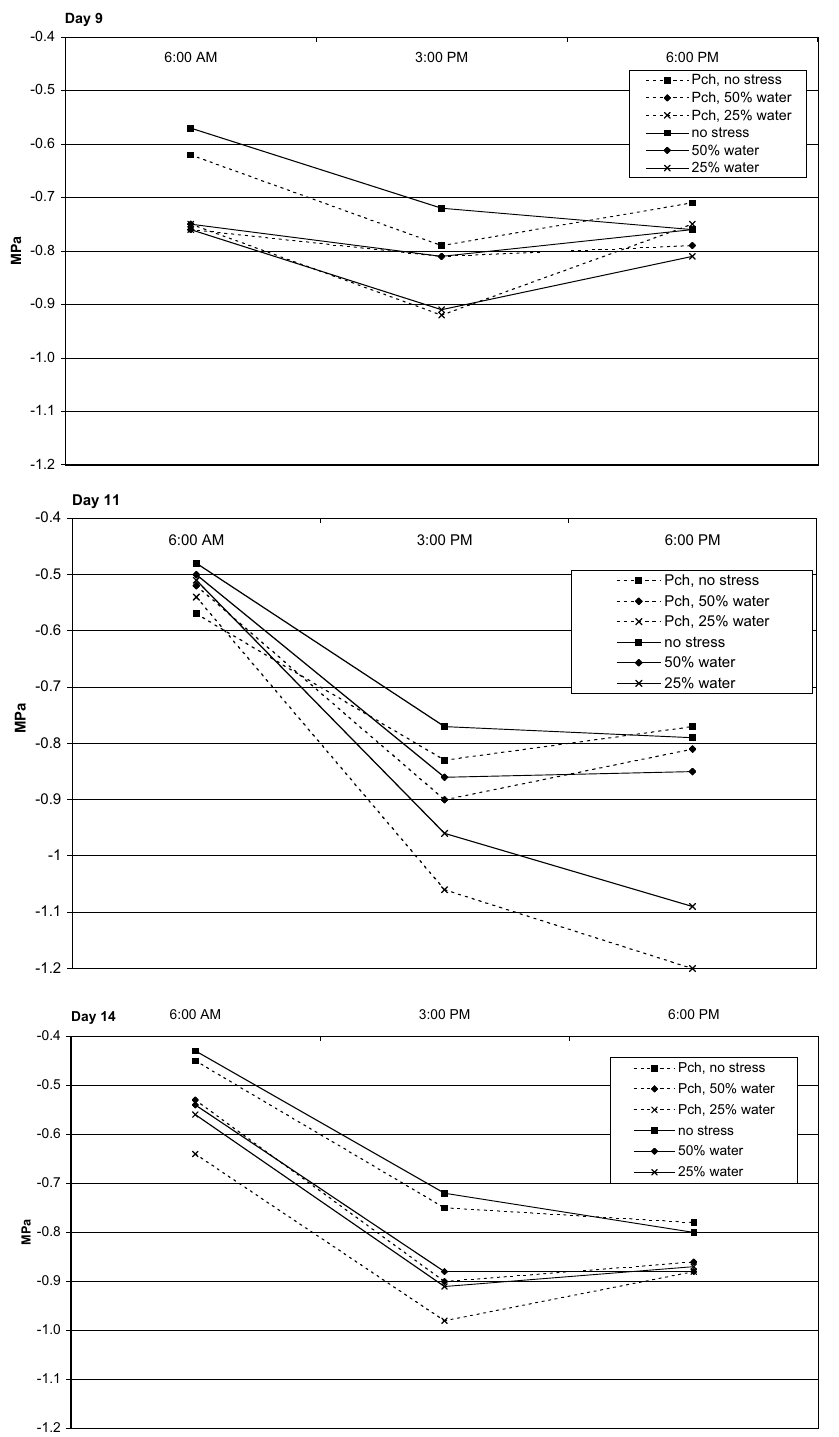
Fig. 4. Effect of 9, 11 and 14 days water stress on leaf water potential of infected and uninfected Cabernet Sauvi- gnon, November